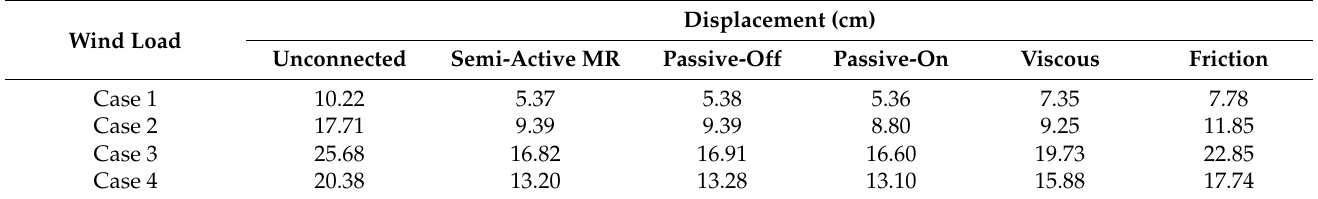
Table 13. Comparison of top storey peak displacement of the coupled flexible building under different control strategies when dampers are arranged in Configuration 1.